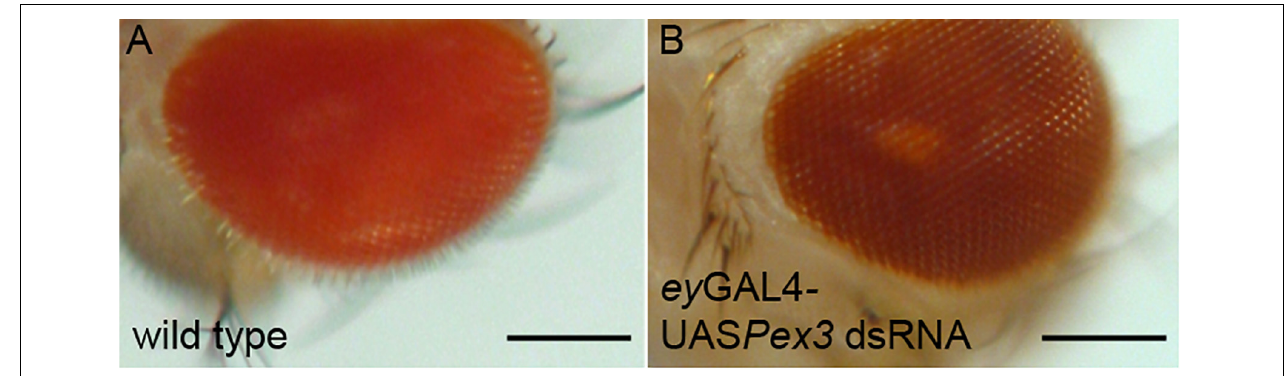
FIGURE 1 | Knockdown of Pex3 in the Drosophila eye phenocopies the Rosy phenotype. (A) Wild type Drosophila eye pigment is a bright red-orange color. (B) Reduction of Pex3 activity specifically in the eye by a combination of eyeless (ey) GAL4 and a UAS inducible transgene expressing a dsRNA targeting Pex3 mRNA causes the characteristic dark red pigmentation associated with ry mutations. Bar = 300 µ m.